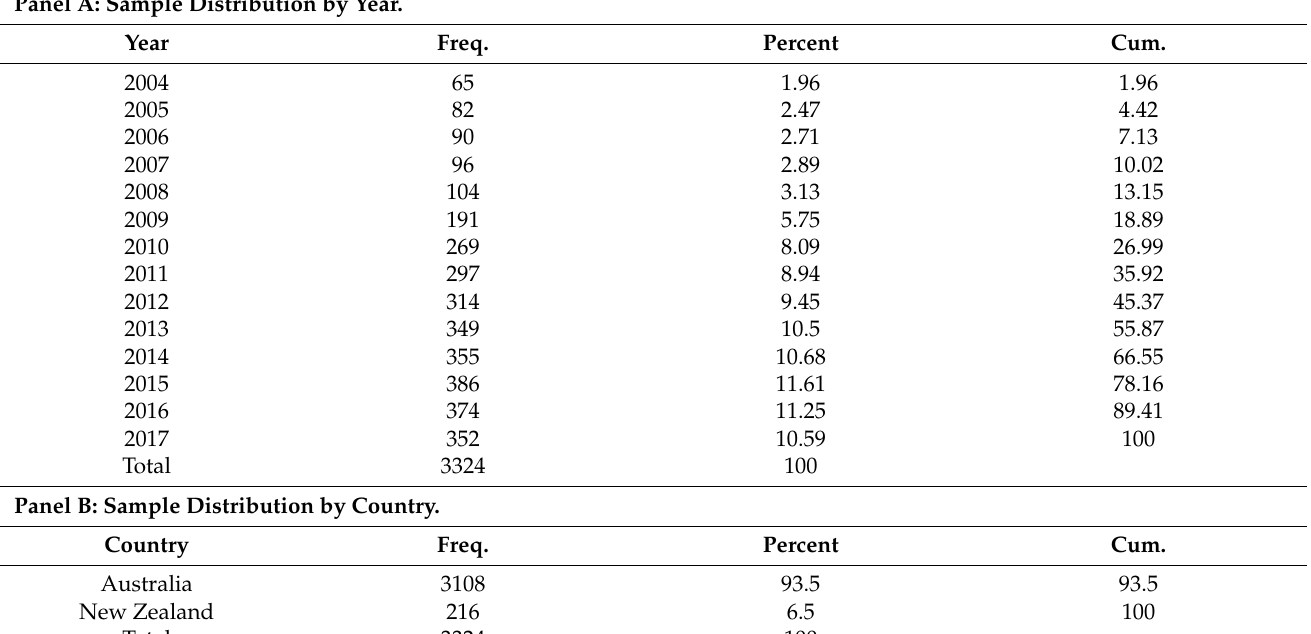
Table 1. Sample descriptive